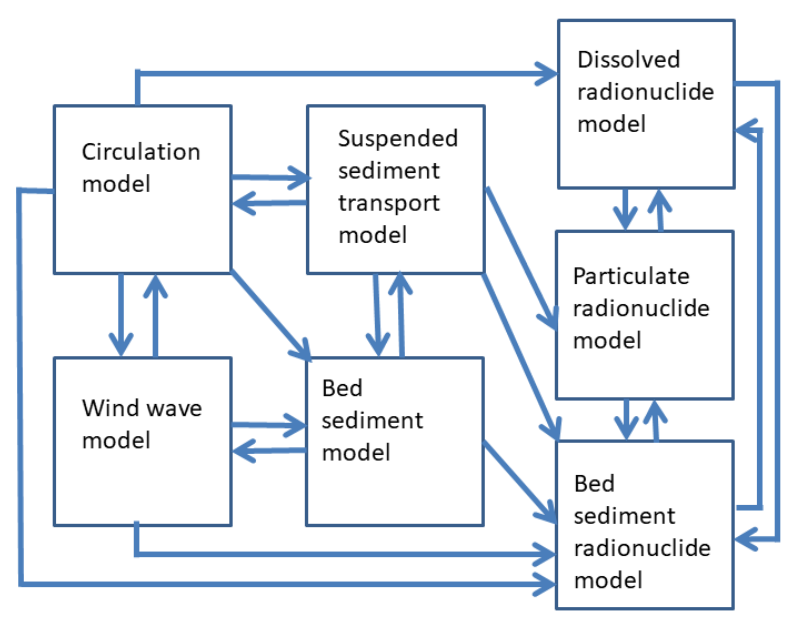
Figure 2. Data flow in the modeling system.